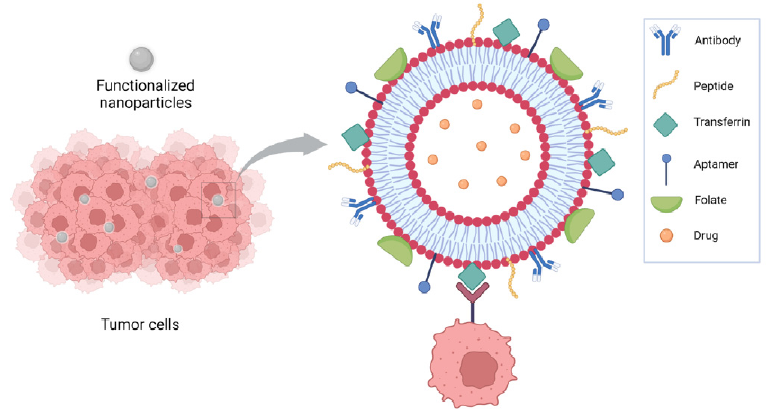
Figure 2. Functionalization of liposomes has been achieved using several approaches including peptides, antibodies, small molecules, and